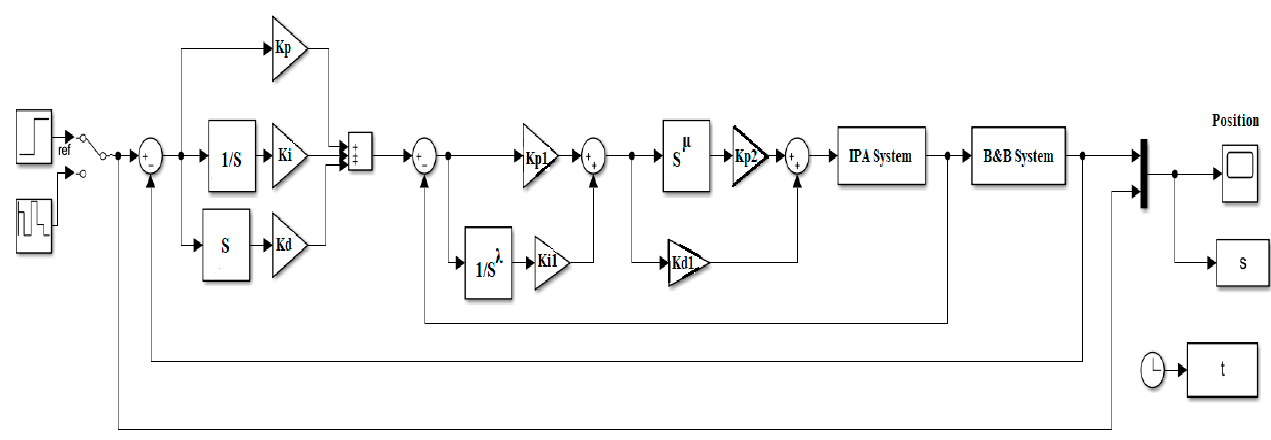
Figure 17. The CFOPID and PID controllers’ responses with varying setpoint. The dynamic performance of the IPABBS based on the CFOPID controller (inner loop), and the PID controller (outer loop) both tuned using the PSO algorithm, repre- sented by rise time, settling time, peak overshoot, and ISE is illustrated in Table 7. The